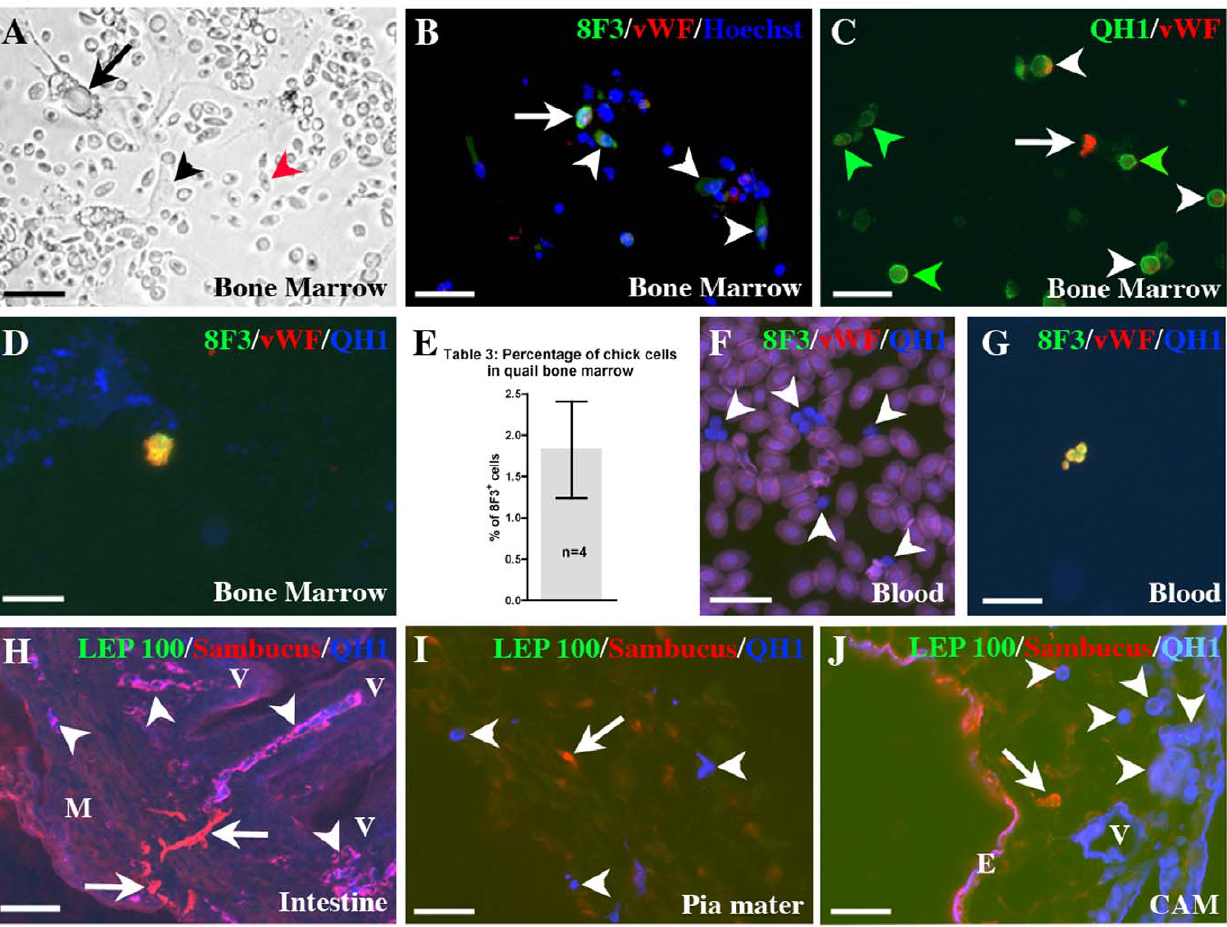
Figure 3. Distribution of chick yolk sac-born CEC in E15 quail chimeras. A–D and F) bone marrow cultures. A) Aspect of a quail bone marrow culture after one day; Adipocytes with oil vacuoles (arrow), fibroblasts with filopodia (black arrowhead) and nucleated erythrocytes (red arrowhead) are easily identified. The round cells present in the culture are HC. Bar: 40 mm. B) 8F3/vWF double staining identifies chick CEC (arrow) among 8F3 + / vWF 2 chick cells (arrowheads). Bar: 20 mm. C) The QH1/vWF double staining shows a chick CEC (arrow) among quail EC (white arrowheads) and HC (green arrowheads). Bar: 20 mm. D) A QH1 2 /vWF + /8F3 + CEC is detected in a bone marrow smear. Bar: 10 mm. E) Table 3: Percentage of chick cells invading the bone marrow in the oldest yolk sac chimeras. The number of 8F3/Hoechst cells is compared with the total cell population in cultures. F ) Presence of QH1 + HSC among nucleated erythrocytes in a blood smear. Bar: 20 mm. G) Identification of a group of QH1 2 /vWF + /8F3 + CEC in a blood smear. Bar: 20 mm. H) Triple staining on a transverse section through the intestine illustrating the participation of chick QH1 2 /Sambucus + /LEP100 2 CEC (arrows) to the vascular plexus of smooth muscle layers (M), beneath a villus (V). The quail host vessels are QH1 + /Sambucus + /LEP100 2 and appear purple (arrowheads). Bar: 40 mm. I) On a pia mater section, an interstitial QH1 2 /Sambucus + /LEP100 2 CEC (arrow) is identified among QH1 + HC (arrowheads). Bar: 20 mm. J) An interstitial QH1 2 /Sambucus + /LEP100 2 CEC (arrow) on a CAM section close to a QH1 + vessel (V) and to QH1 + HC (arrowheads). Note that the endodermal layer (E) of the CAM is underlined by Sambucus and QH1 and appears purple. Bar: 20